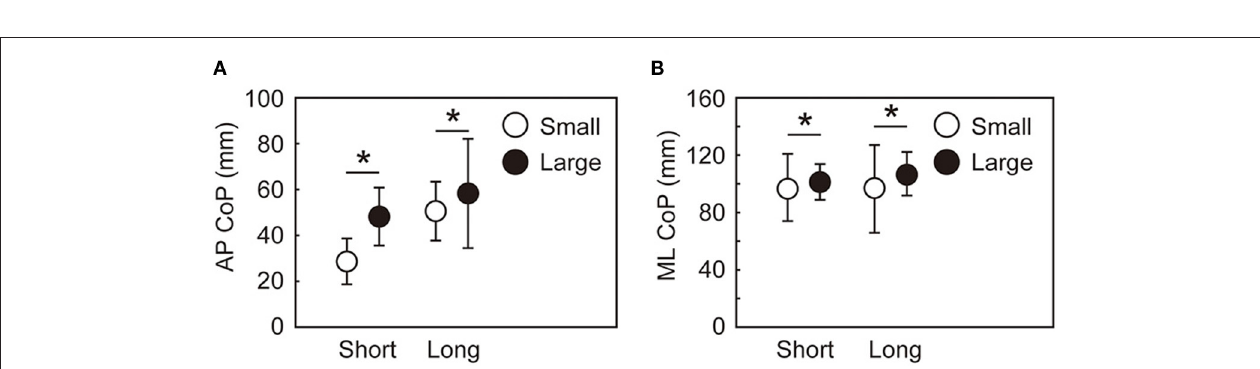
FIGURE 4 | Maximum CoP displacement during the APA along with the AP (A) and ML (B) axes. Between-participant means and standard deviations are shown. *Indicates a significant difference between the small and large conditions ( p < 0.025).